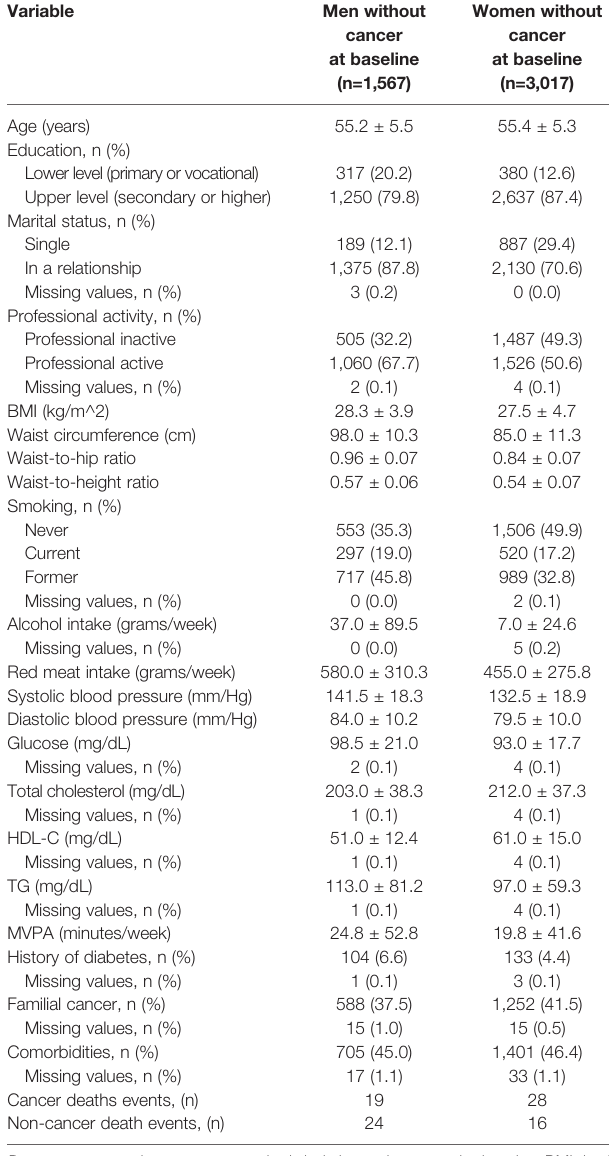
TABLE 1 | Basic characteristics of study group, strati fi ed by